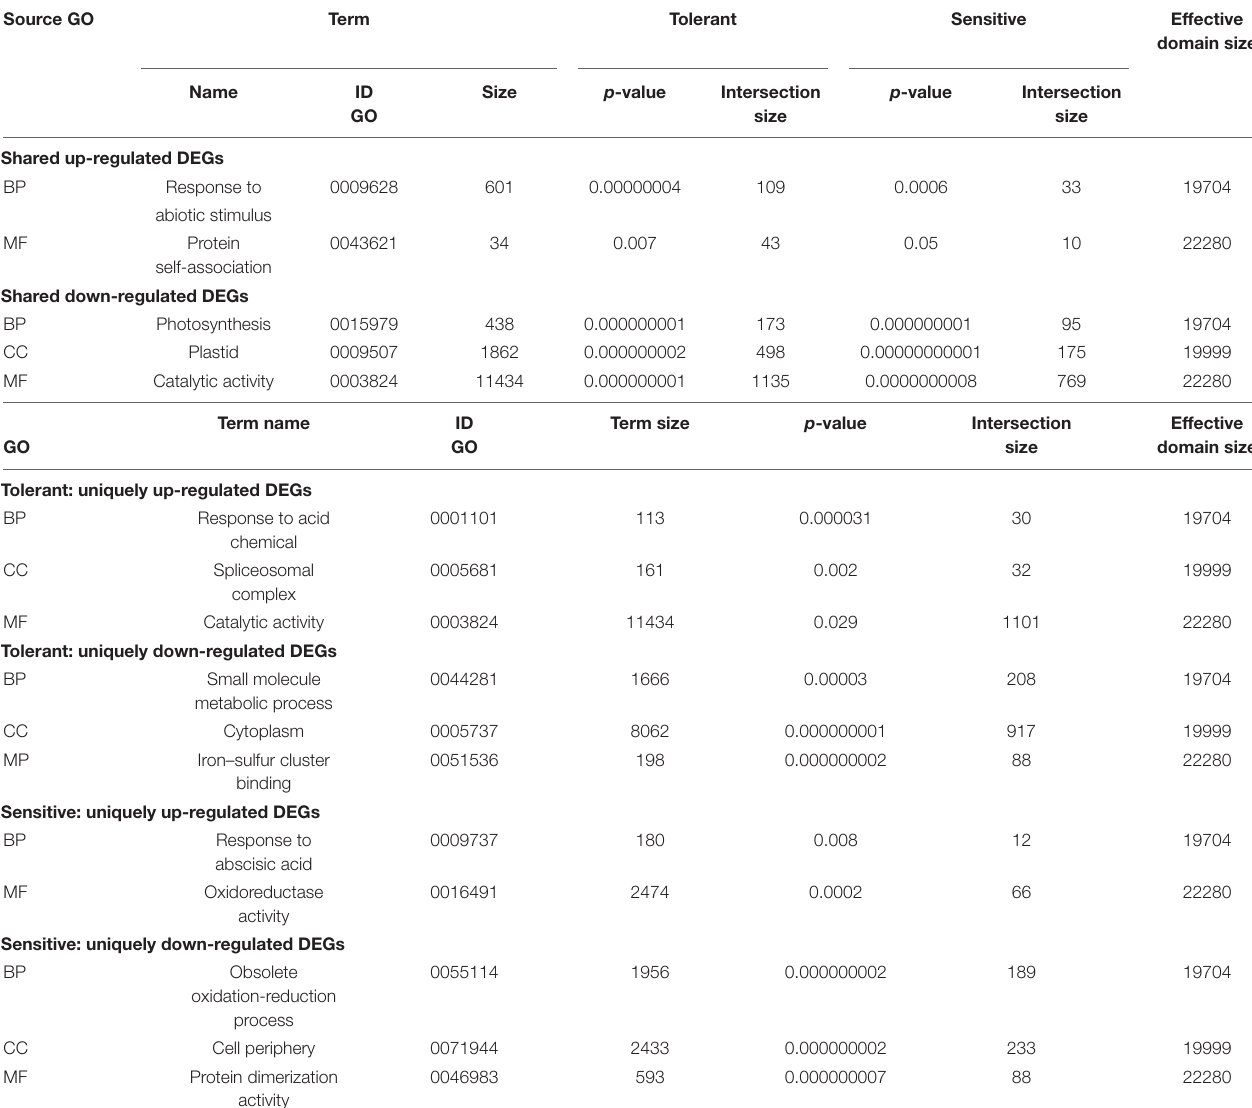
TABLE 3 | Unique and shared enriched functional categories of DEGs in tolerant ( H. spontaneum ) and sensitive ( H. vulgare ) in response to salt stress annotating by GO term. Source GO Term Tolerant Sensitive Effective